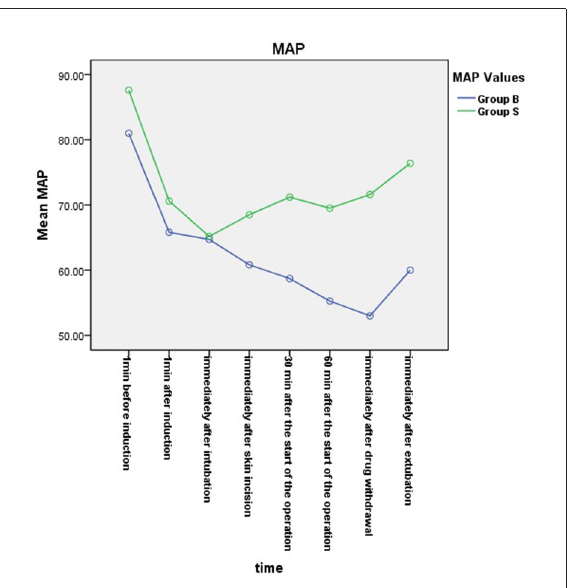
FIGURE4 Mean arterial pressure (MAP) changes in the two groups. The MAP values significantly differed among the eight time points as well as between the two groups ( P < 0.05). MAP in group B was lower than in group S at 30min after the start of the operation, 60min after the start of operation, immediately after drug withdrawal, and immediately after extubation ( P <